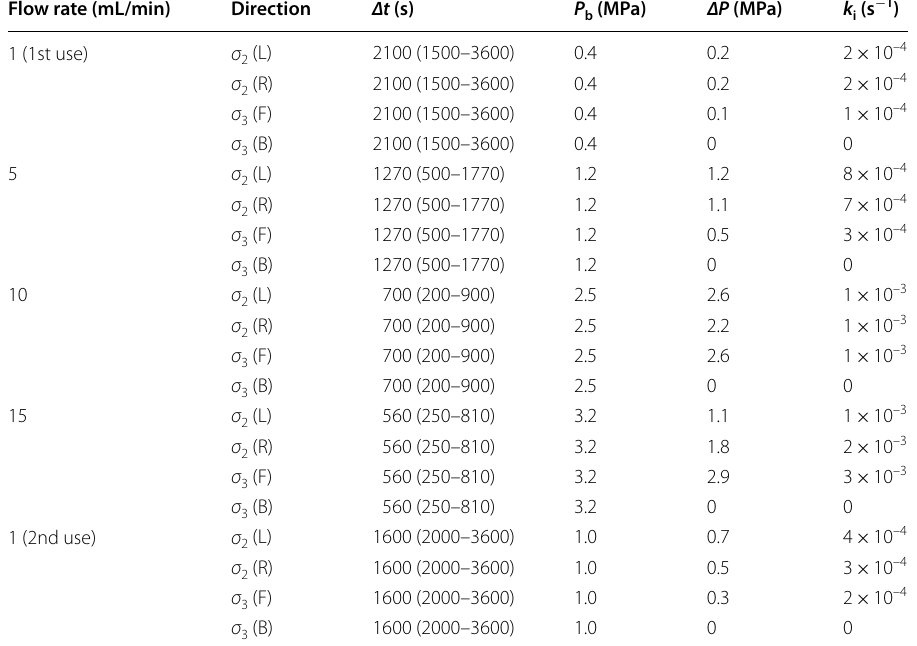
σ x (y) in the second column denotes the outlet face, y (R: right face, L: left face, F: front face, B: back face) subjected to the principal stress, σ x (x: 1, 2, 3)